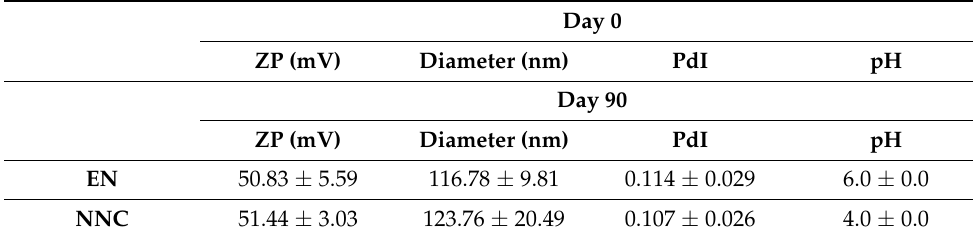
Table 2. pH of freshly made empty nanocapsules (EN) and nicotine containing nanocapsule (NNC) suspensions. Results are displayed as mean ± standard deviation.